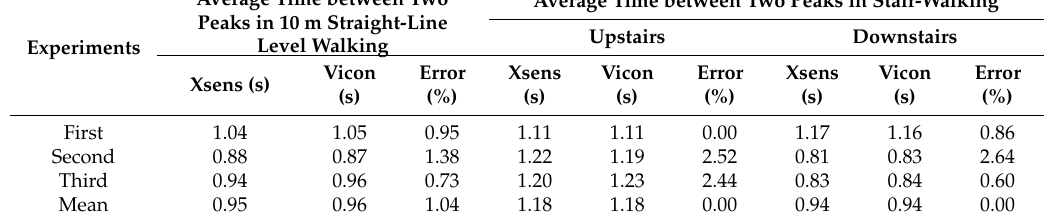
Table 1. Comparison of the peak points with the heel-contact events.